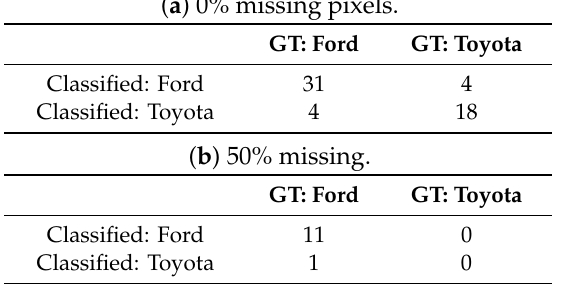
Table 6. Confusion matrices for the IMG428 video with YOLO